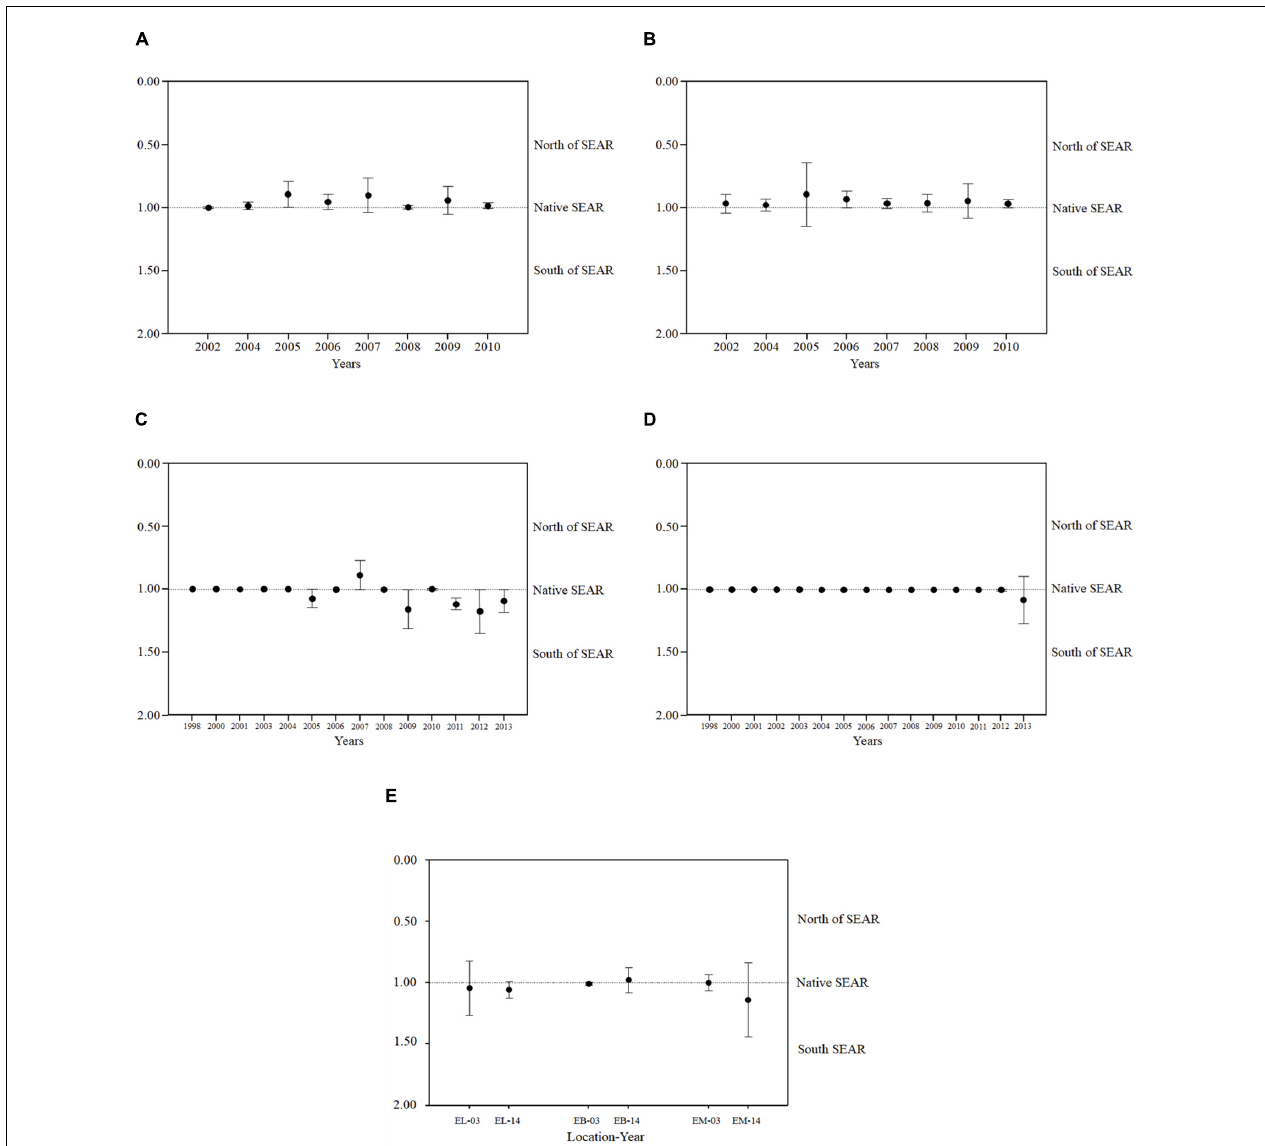
FIGURE 3 | Species distribution calculated for (A) Porto Buxo (PB); (B) Portinho da Costa (PC); (C) Parque das Nações Subtidal (PNS); (D) Parque das Nações Intertidal (PNI), and (E) Estuary—Estuary Lower (EL); Estuarine Bays (EB), Estuary Med (EM); Median distribution of abundance of individuals sampled during the timescale of the study. 1. Abundance of individuals native to the South European Atlantic Shelf Eco Region (SEASER); 0. Abundance of individuals native to the ecoregions North of the SEASER; 2. Abundance of individuals Native to the ecoregions South of SEASER. Deviation from 1 indicates whether there is a bigger influence from northern or southern fauna in the benthic